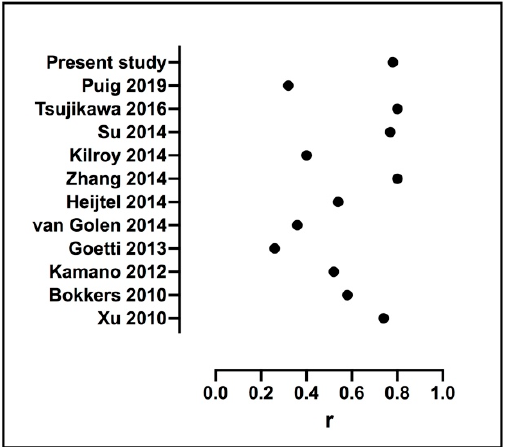
Figure 4. Previously reported correlation coefficients between GM CBF derived from 15 O-water PET and ASL. and